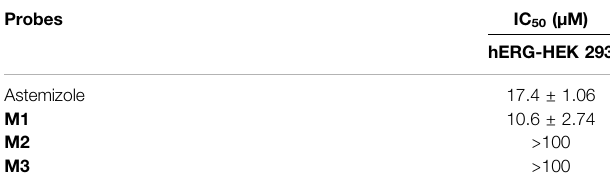
TABLE 2 | Cytotoxicity of fl uorescent probes for hERG-transfected